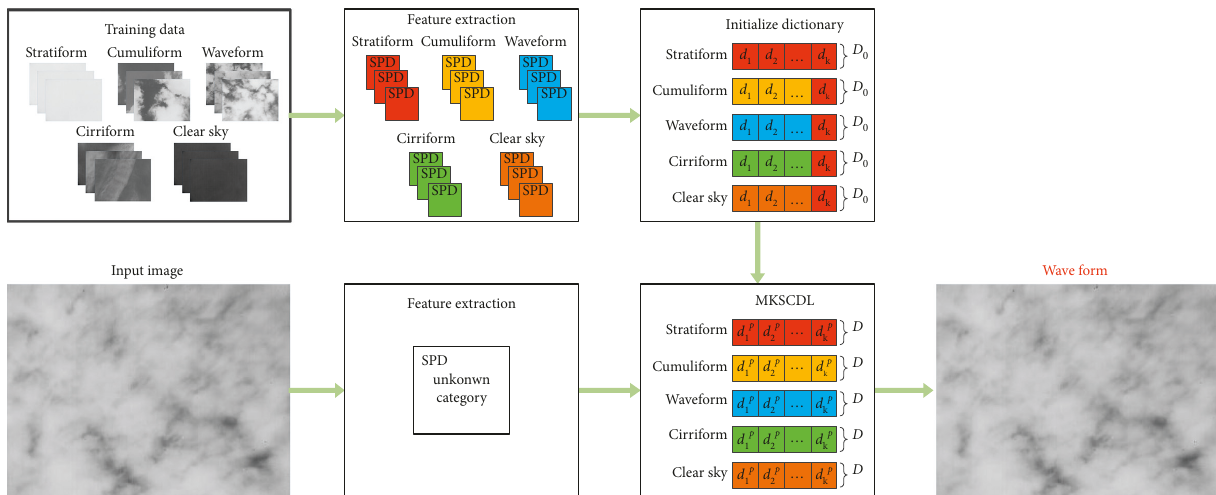
Figure 3: Framework of the proposed cloud classification